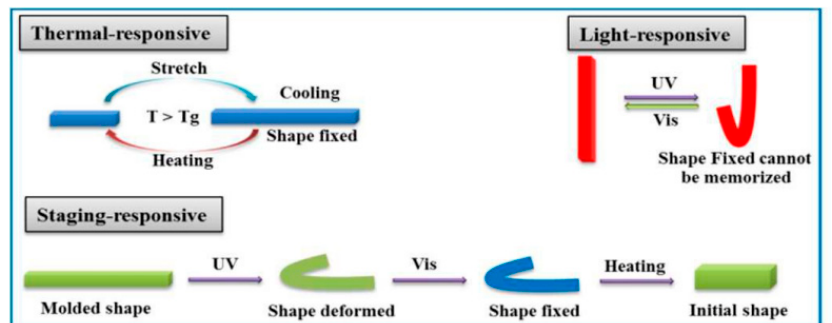
Figure 11. Illustration of the staging-responsive shape memory effect (SME) compared to the thermally responsive and light-responsive SMEs. (A traditional TSMP is deformed into a temporary shape and then recovered by “hot programming”, while a traditional LSMP can be deformed under UV light and promptly recovered using another light stimulus, e.g., Vis light. For the SR-SMPs, samples were first directionally oriented. They spontaneously deformed into a temporary shape by “UV programming”, and this deformed shape was unchangeable even under irradiation by Vis light. Only “hot programming” allowed the initial shape to be recovered [82].)